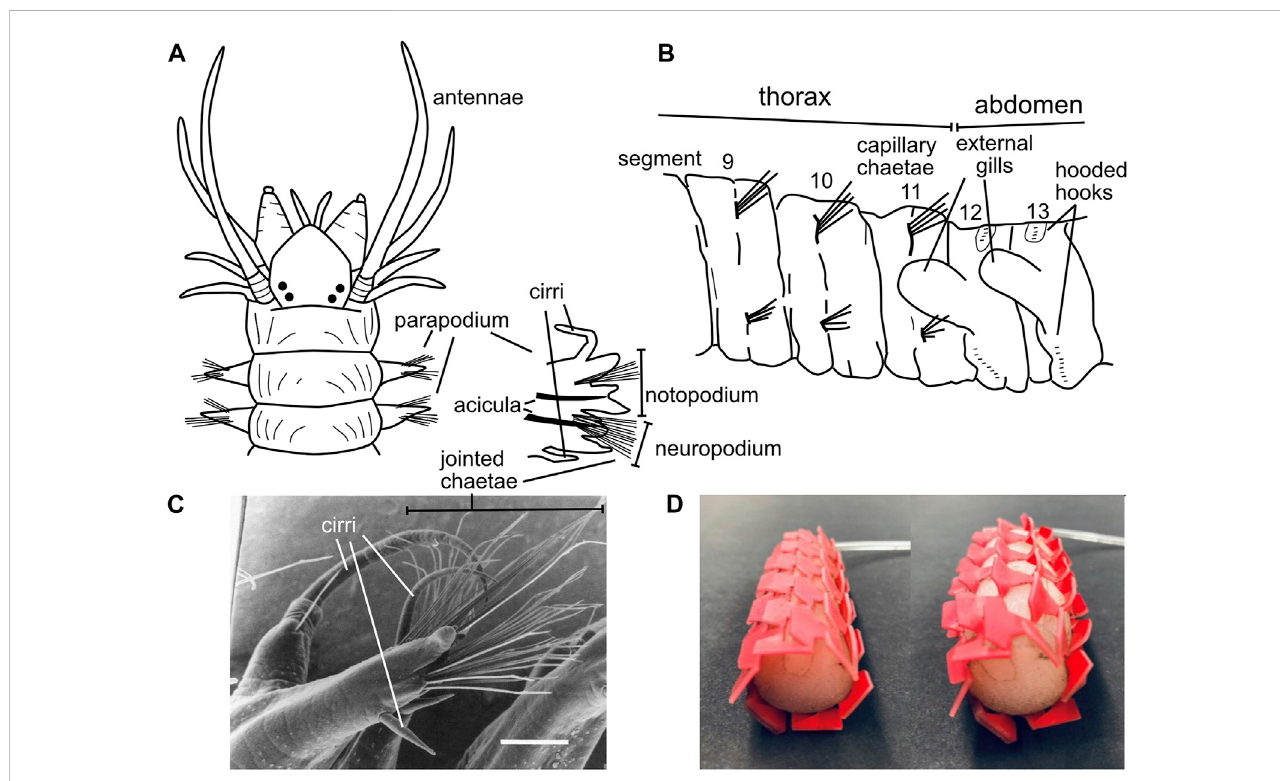
FIGURE 10 (A) Drawing showing parapodia with chaetae at the anterior of Alitta succinea (Nereididae), with one anterior parapodium enlarged to show the upper notopodium and lower neuropodium, the rigid acicula to support the parapodium, bundles of chaetae, and sensory cirri (B) Drawing of chaetae of Notomastuslineatus (Capitellidae)atthetransitionfromthestraightcapillarychaetaeofthemoreanteriorthorax(anterior11segments) toveryshort,hooded hooks in the abdomen. Parapodia are so reduced as to be invisible in this drawing. (C) Image of a mid-body parapodium of Ophiodromus pugettensis (Hesionidae) from a ventral anterior view showing jointed chaetae bending back toward the posterior of the worm; scale bar is 200 μ m (D) Image of kirigami skinonanearthworm-inspiredrobotshowingsmootherpro fi leunderlowpressure(left)andridgesthatpopoutunderhighpressuretoincreasefriction(right) (A,B) Drawings modi fi ed from Uebelacker et al., 1984; (C) reproduced from Figure 1 of Merz, 1998 with permission. (D) Reproduced from Figure 6 of Liu et al. (2019) with